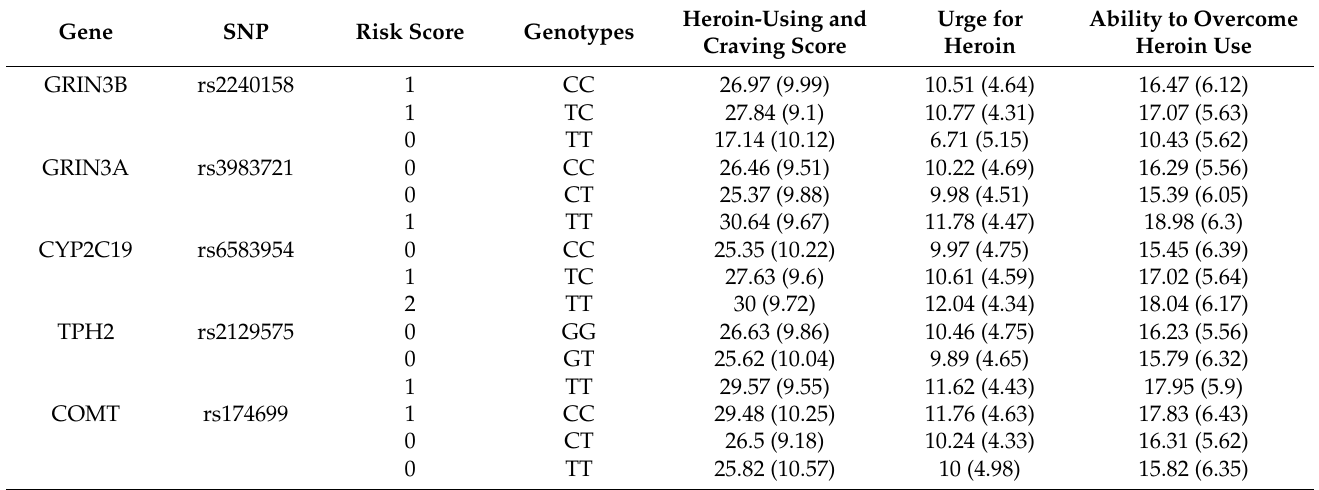
Table 3. Averaged heroin-using and craving score stratified according to genotypes of variants in reward pathway genes. Gene